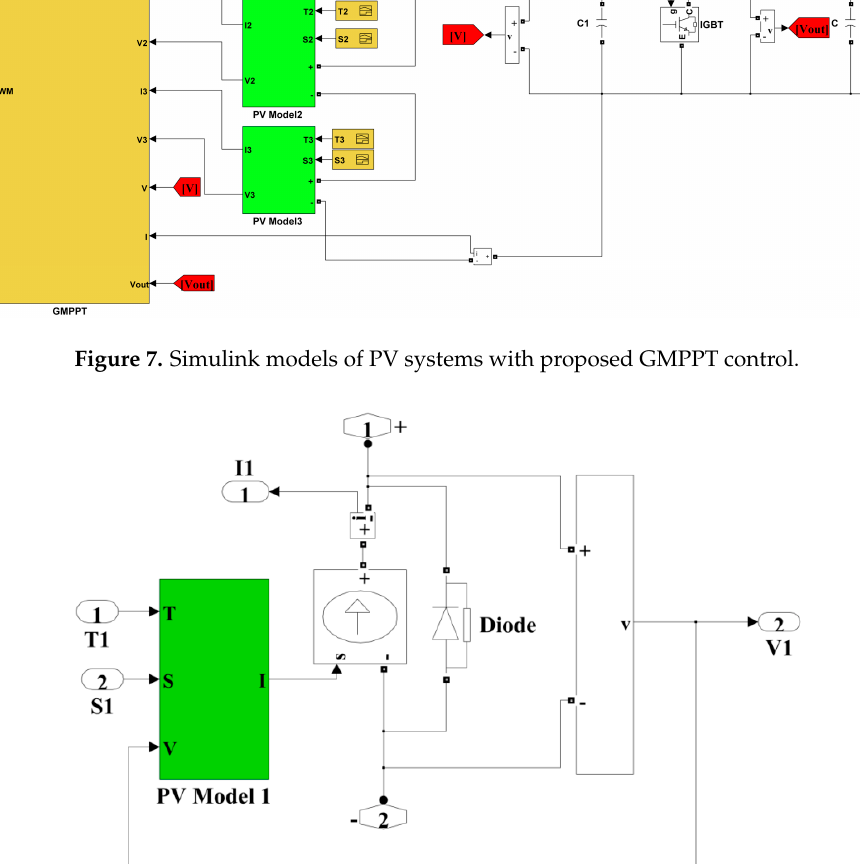
Figure 8. Simulink/SimPower model of one PV module.